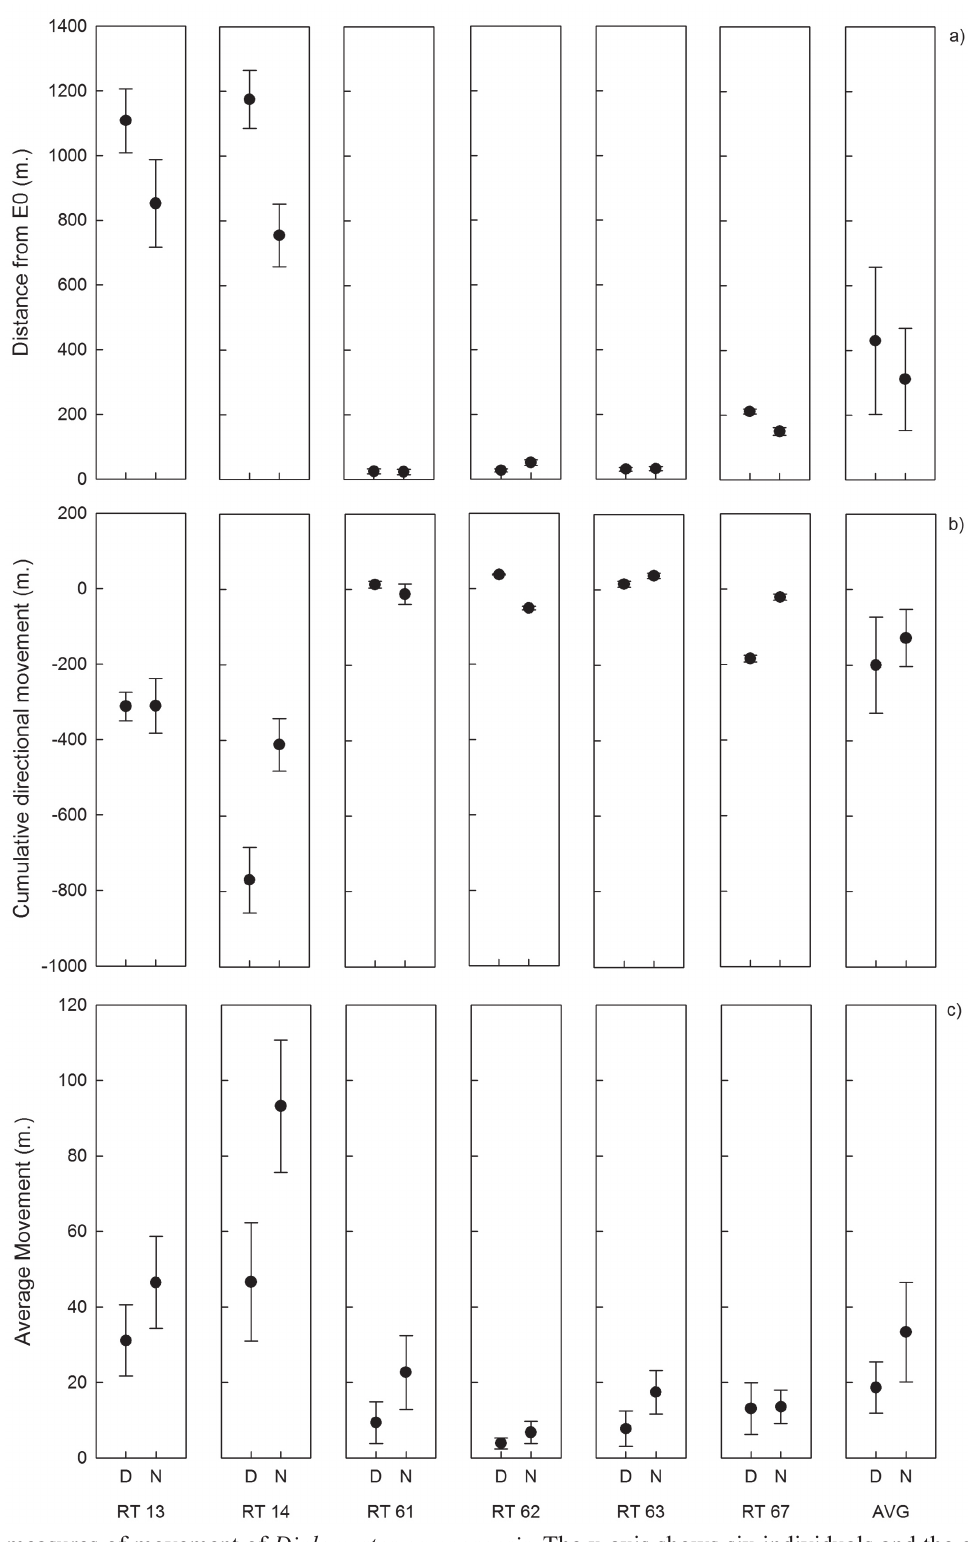
Fig. 3. Three measures of movement of Diplomystes camposensis . The x-axis shows six individuals and the combined data during day (D) and night time (N). The y-axis shows values of a) distance from E0 (m); b) Cumulative directional movement (m), and c) Average movement (m), differentiating between displacements upstream (positive) or downstream (negative) in direction. Black squares show mean value and whiskers show standard error. Individual R 52 not included here due to the lack of night